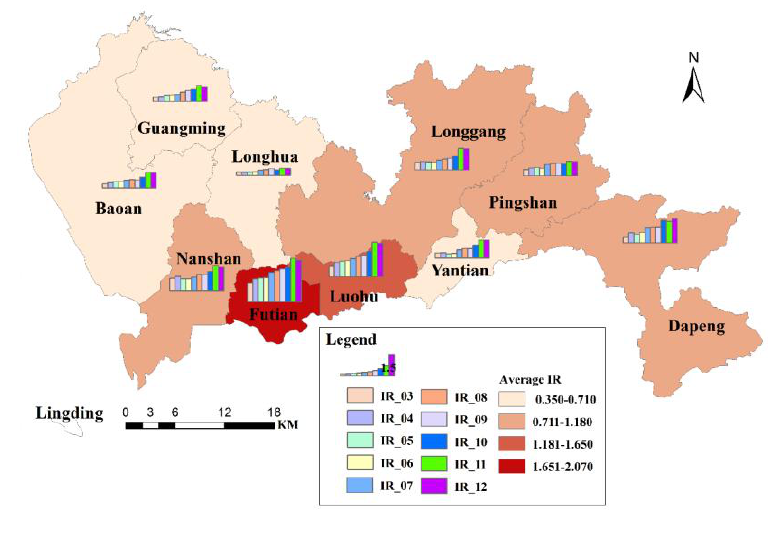
Figure 4. The map of the IRs and total hospital admissions of IHD from 2003 to 2012 at the district level in Shenzhen.